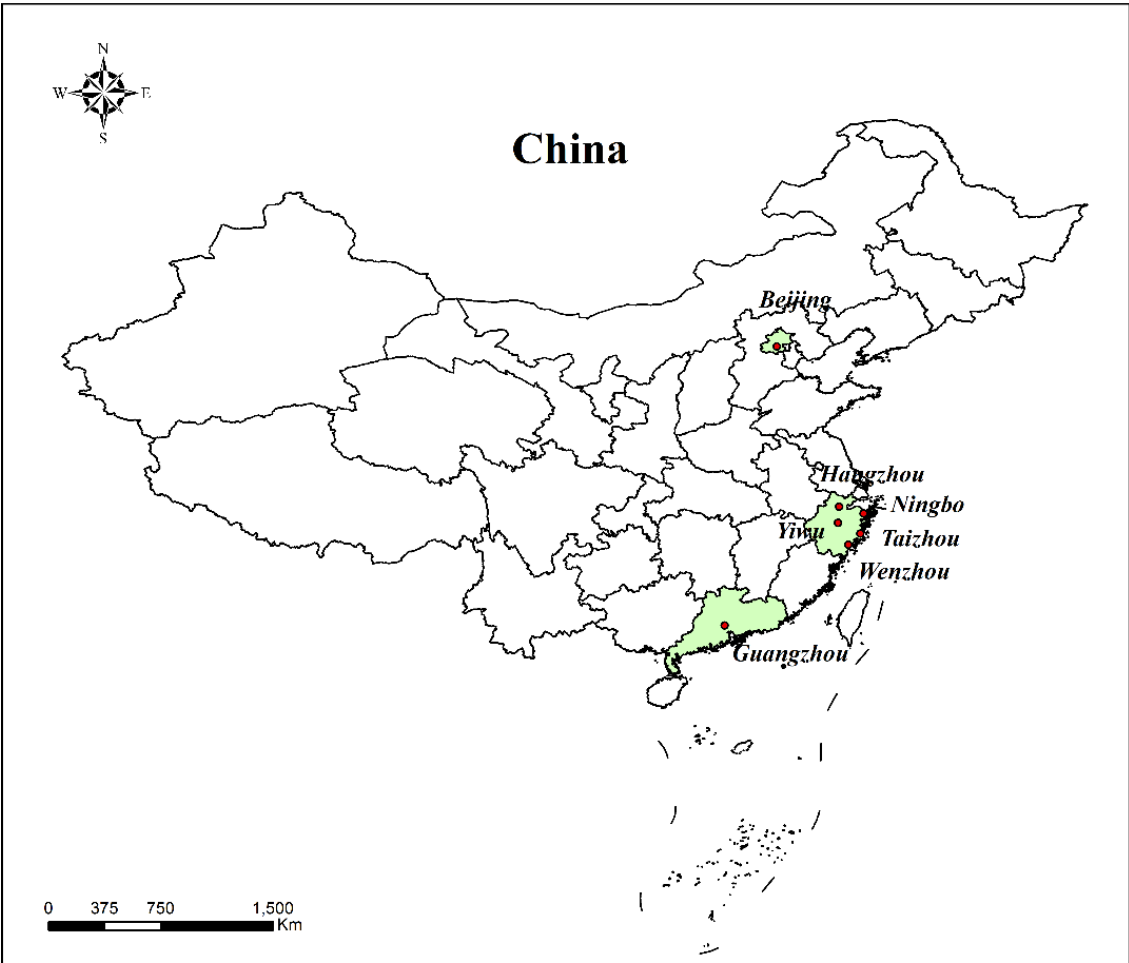
Figure 1. The location of study sites (by the first author).